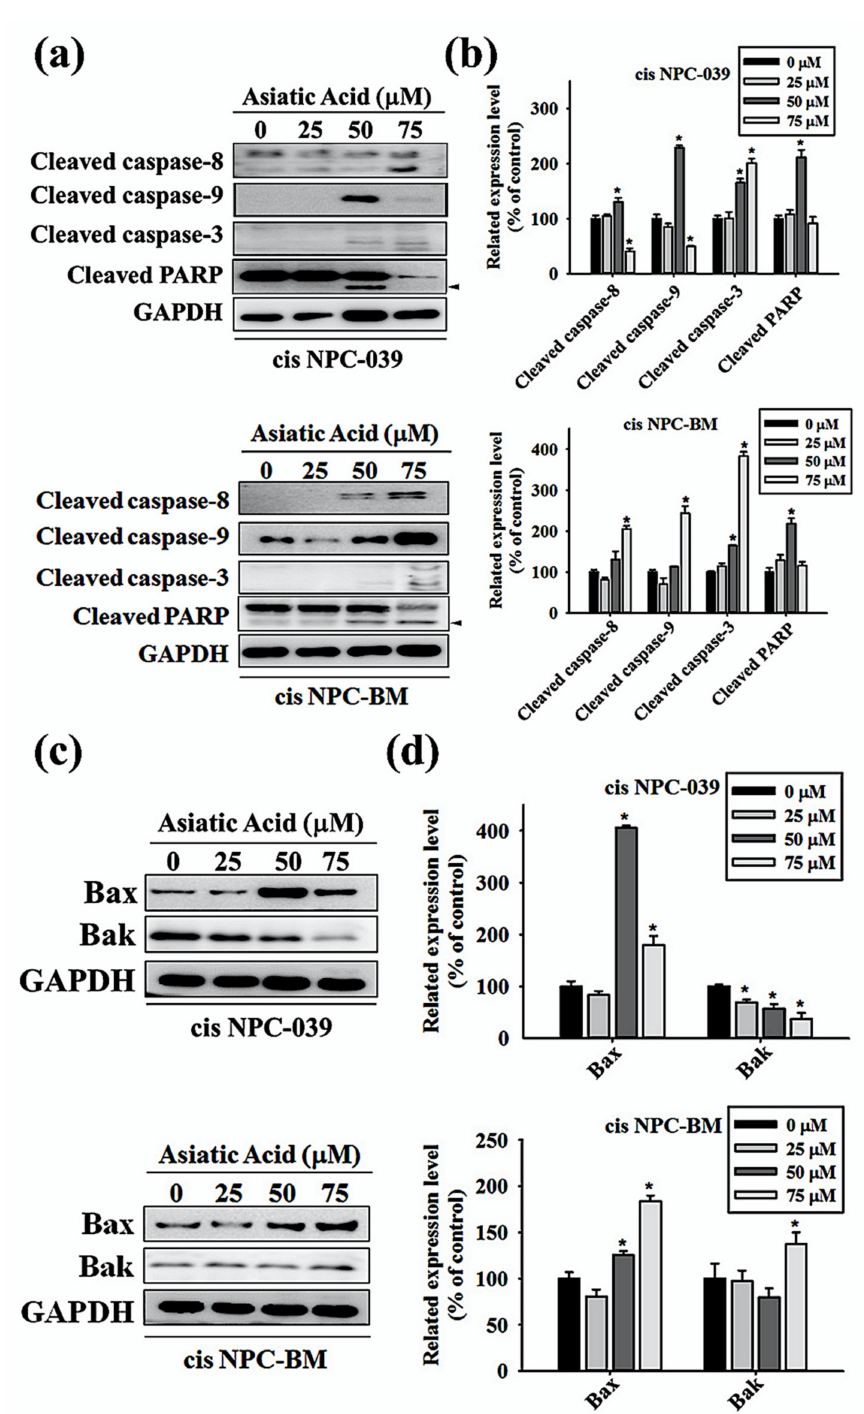
Figure 5. Asiatic acid activates caspase 3, 8, and 9 and upregulated the expression of Bax and Bak. ( a ) The expression levels of cleaved caspase-3, -8, -9 and PARP were detected by Western blot. ( b ) The protein levels were quantified and normalized to GAPDH using a densitometer. ( c ) The expression levels of Bak and Bak were detected by Western blot. ( d ) The protein levels were quantified and normalized to GAPDH using a densitometer. * p < 0.05 versus control